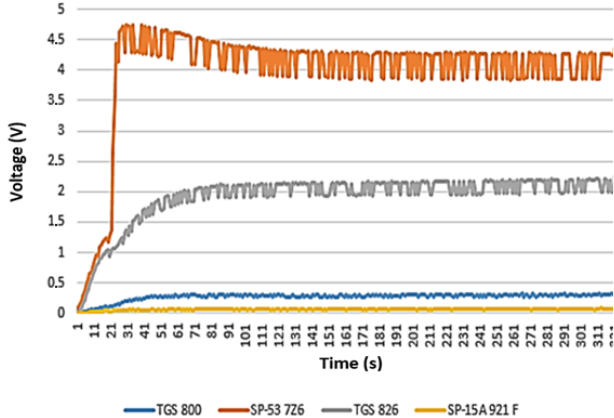
Figure 9. Response of the sensors to a PWM signal with a 33.3% duty cycle, on the heater resistor (alcohol [70%]).